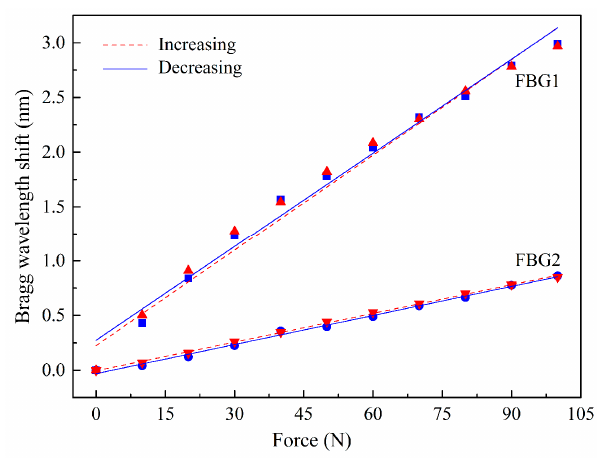
Figure 5. Bragg wavelength shifts as function of increasing and decreasing loadings.